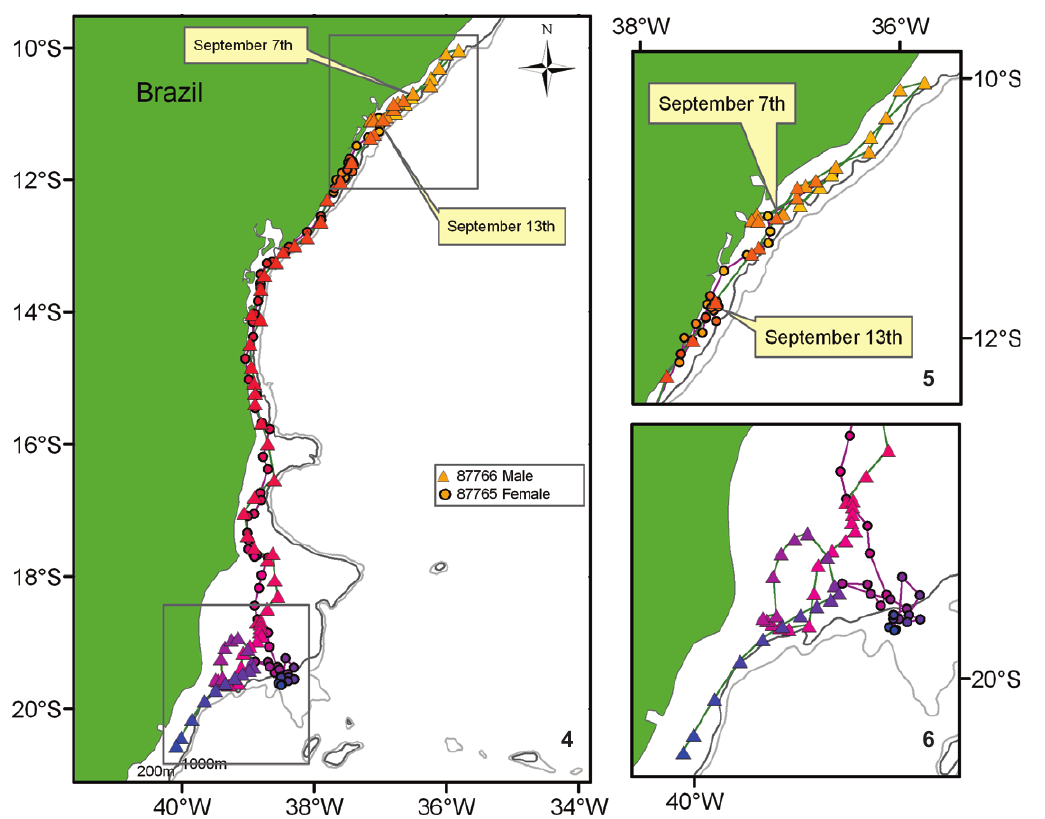
Figures 4-6. Movements of humpback whale Pair C tagged on the Brazilian breeding grounds: (4) overview of the tracks; (5) tracks after deployment; (6) shows the end of the monitoring period. The same colors correspond to the same dates for each